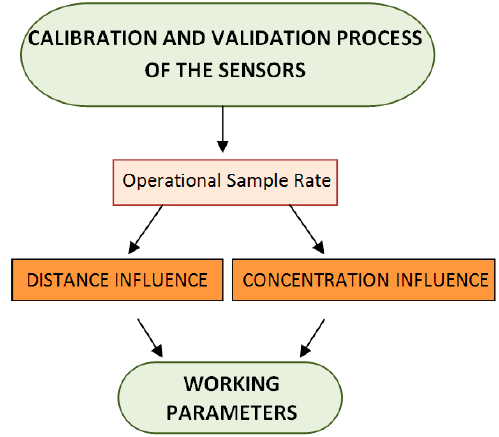
Figure 1. Work flow carried out for each sensor.